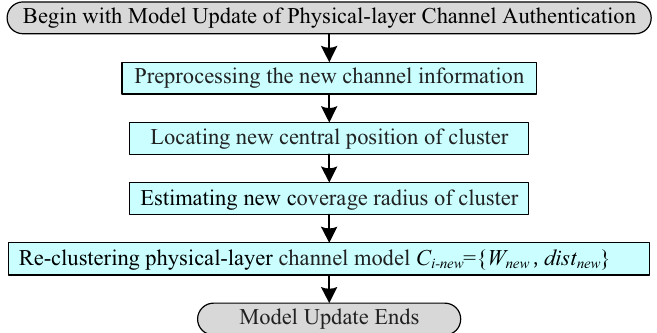
Figure 9. Process flowchart of model update of physical-layer channel